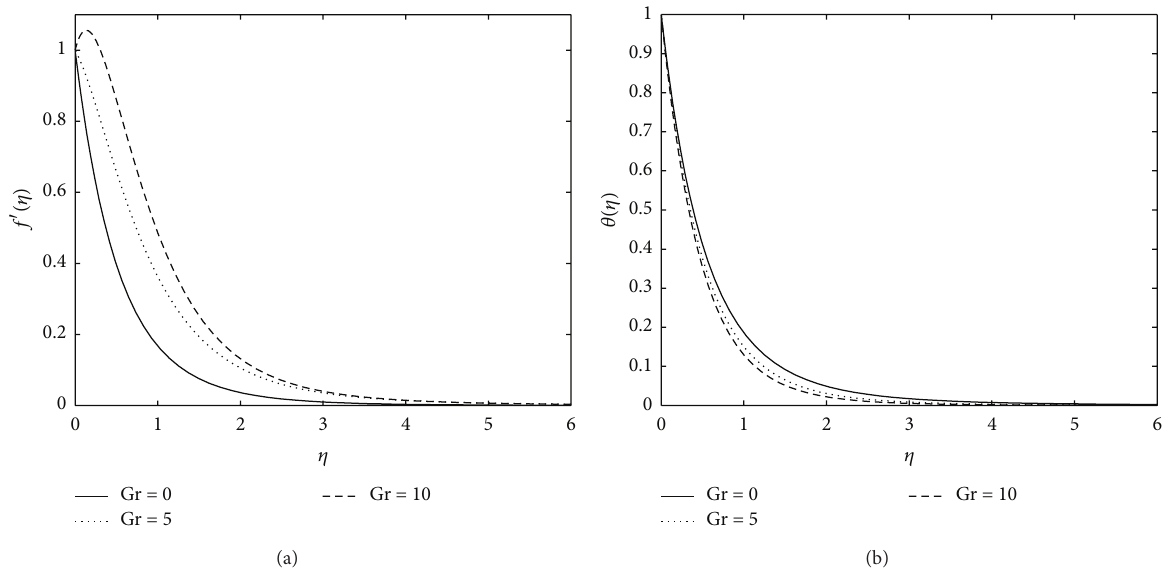
Figure 7: Effect of Gr on the velocity and temperature